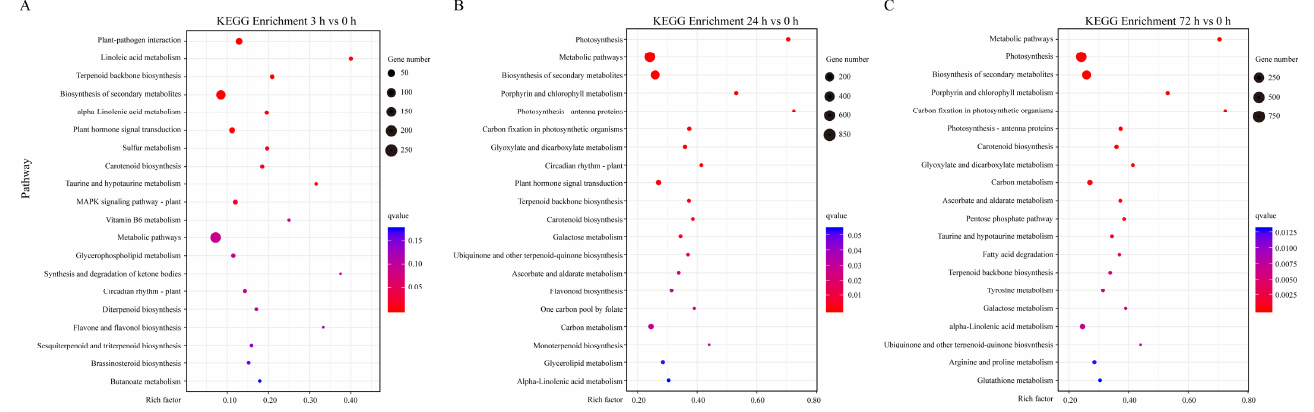
Figure 5. KEGG enrichment analysis of DEGs in different groups. ( A ) KEGG enrichment analysis of the DEGs in response to sucrose treatment for 3 h and 0 h. ( B ) KEGG enrichment analysis of the DEGs in response to sucrose treatment for 24 h and 0 h. ( C ) KEGG enrichment analysis of the DEGs in response to sucrose treatment for 72 h and 0